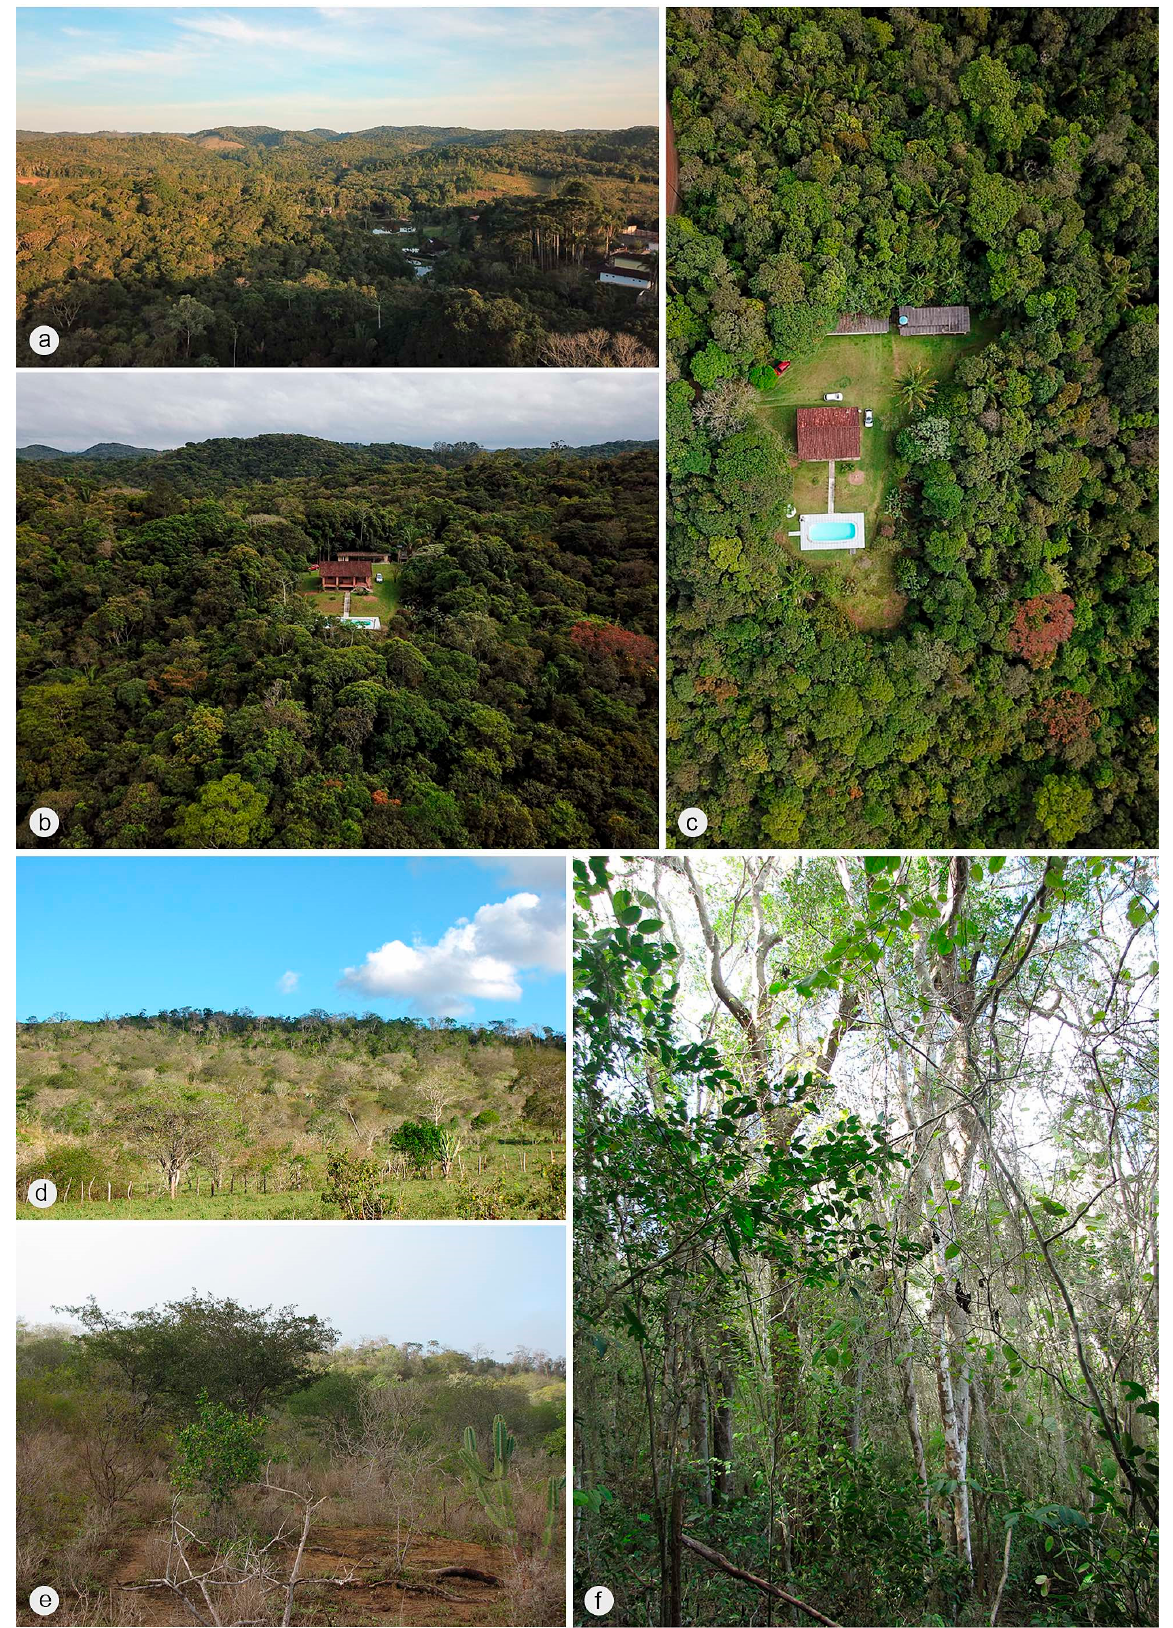
Figure 7. Collecting sites of Jurasai species ( a – c ) Juquitiba (São Paulo state, Brazil), type locality of J. vanini sp. nov., located in a region of dense ombrophilous forest; ( d – f ) Milagres (Bahia state, Brazil), type locality of J. miraculum sp. nov., located in a region of arboreal Caatinga, a seasonally dry tropical forest in a transitional area with the Atlantic Forest.